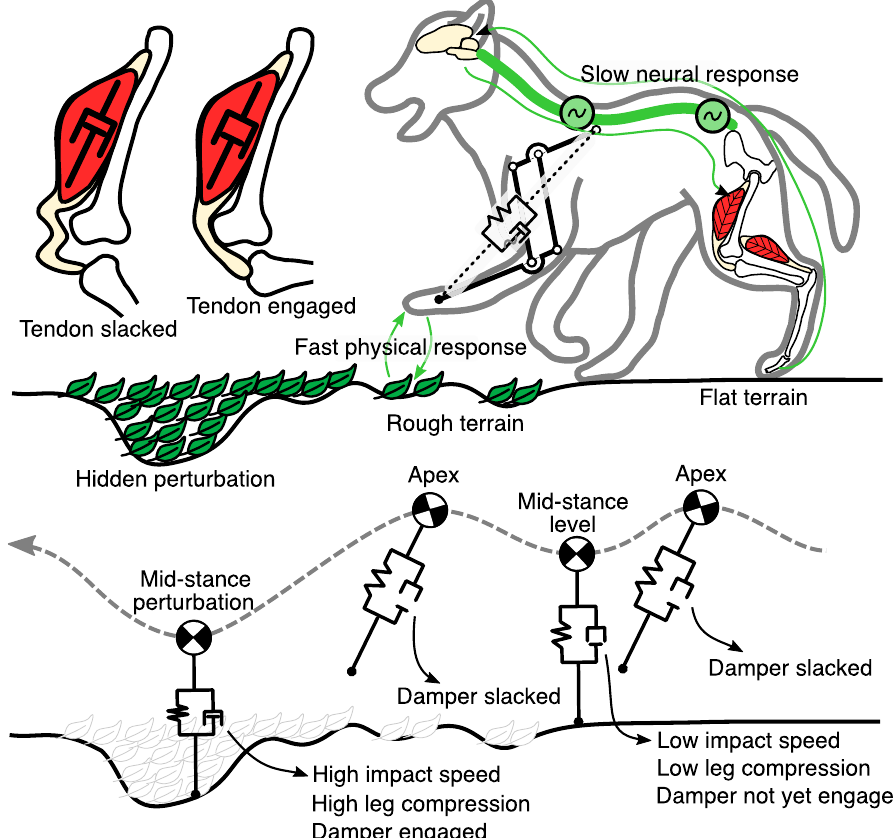
Figure 1. Top: Fast running over ground perturbation is challenging. Due to sensorimotor delays up to 50 ms, the central nervous system struggles to perceive and react to sudden ground disturbances 1 . In contrast, the intrinsic mechanics of the musculoskeletal system act like a spring damper. They produce a physical and, therefore, immediate (< 5 ms) reaction when in contact with the environment. We hypothesize that the leg damping mitigates ground disturbance through adaptive force production and energy dissipation. The tendon’s slack, coupled with the joint’s motion, auto-engages the damper. This creates a trade-off between locomotion robustness and energetic efficiency. Bottom: The damper slack enables perturbation-triggered damping. Sufficiently slacked, the damper does not engage during stance, and only spring-based torque is produced. When encountering a perturbation, the leg’s compression increases further, removing all damper slack, and the damper engages in parallel to the